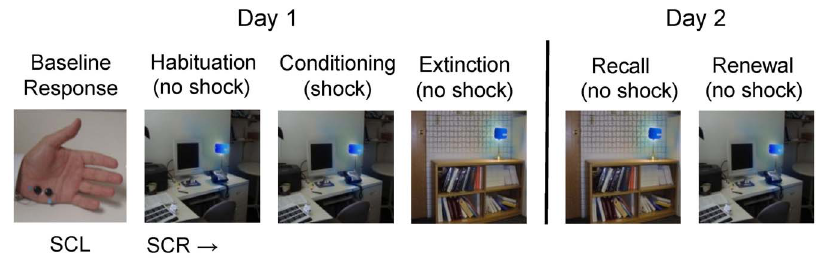
Fig. 1. Schematic representation of research protocol. Electrodes measuring skin conductance response (SCR) are placed on the palm of the non-dominant hand while shock electrodes were placed on the dominant hand fingers. Subjects first encounter all the images without any shock (habituation) and then in one of the contexts (office) the blue light will be paired with a shock while the red light receives no shock (conditioning). The other context (library) is then shown with no shocks neither in the blue or red light (extinction). Approximately 24 hours later, subjects return and their SCR is measured while seeing the extinction context with no shock (recall) and the conditioning context with no shock (renewal). SCL 5 skin conductance level, SCR 5 skin conductance